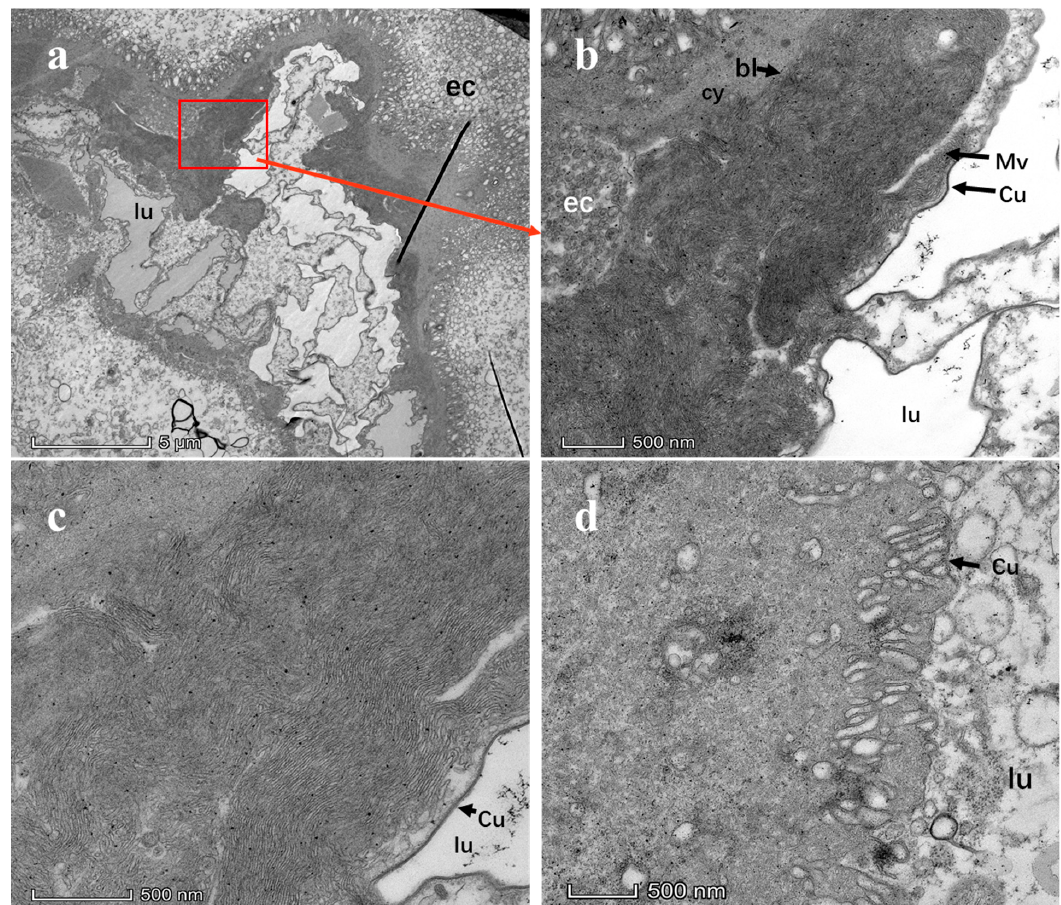
Figure 7. Transmission electron microscopy images of D . citri midguts with and without Citrus tristeza virus (CTV). ( a ) TEM images of D . citri midguts carrying CTV at a magni fi cation of 2600; ( b ) TEM images of midguts of D . citri carrying CTV at a magni fi cation of 13500; ( c ) TEM images of midguts of D . citri carrying CTV at a magni fi cation of 22000; ( d ) TEM images of midguts of healthy D . citri at a magni fi cation of 22,000. Lu: lumen; Cy: cytoplasm; ec: epithelial cell; bl: basal lamina; mv: microvilli; Va: Cytoplasmic vacuoles; Cu: cuticle.